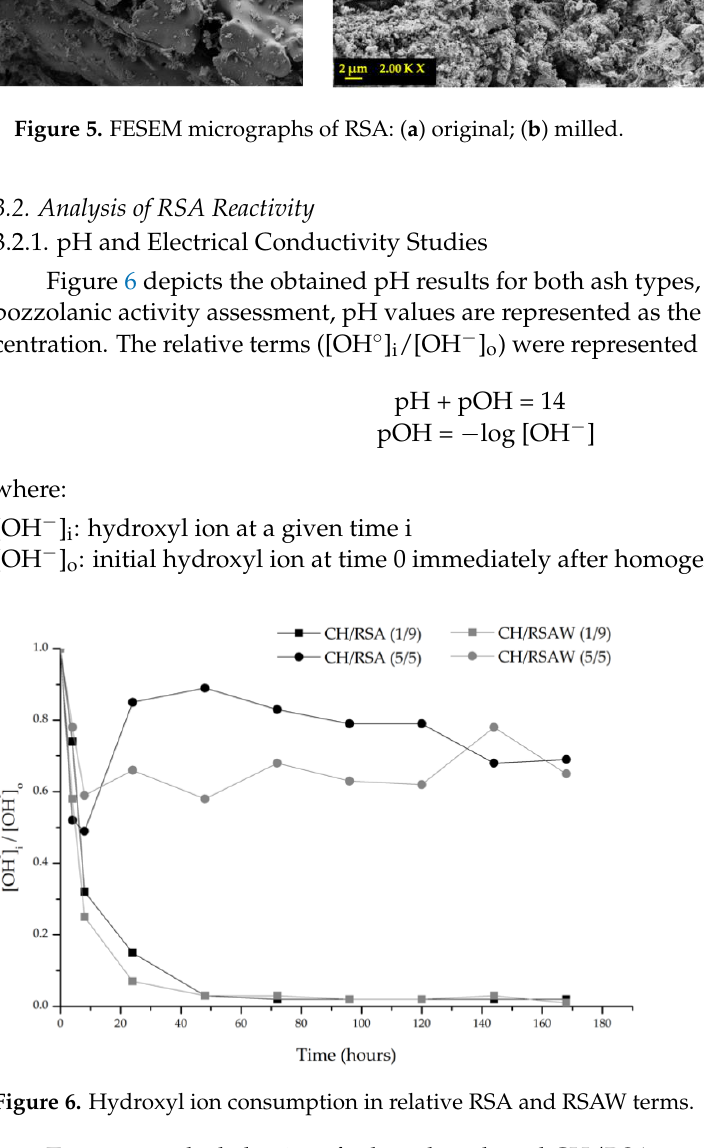
Figure 5. FESEM micrographs of RSA: ( a ) original; ( b ) milled.